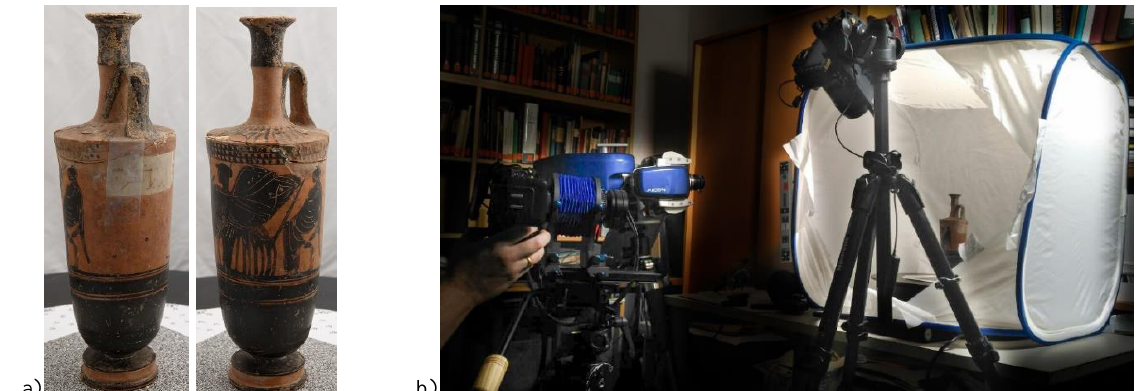
Figure 1. The Attic vase used in the investigation (a) and the acquisition set-up with a fringe projection scanner and two digital cameras